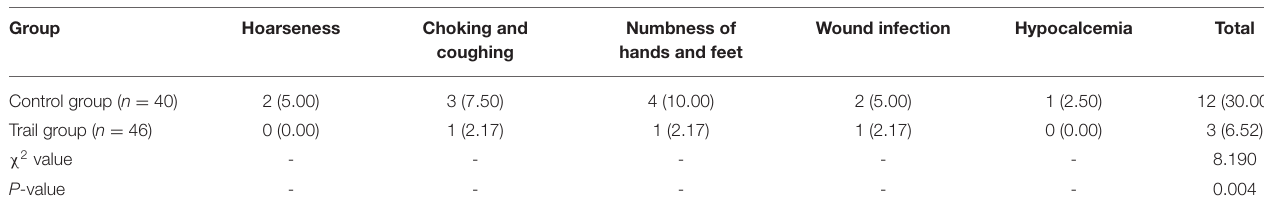
Numbness of coughing hands and